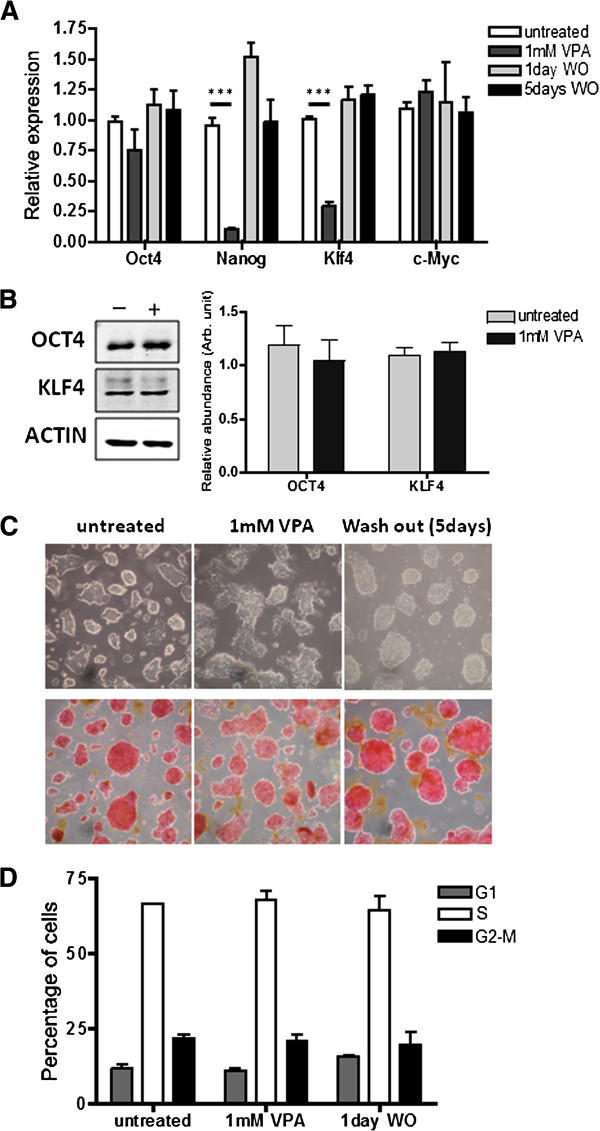
Valproic acid reduces expression of selected pluripotency genes but does not trigger long-term changes in cell growth or differentiation. (A) Embryonic stem (ES) cells (CCE/R) were treated for 8 h with 1 mM valproic acid (VPA) followed by culture for one or five days in the absence of the drug (wash out, WO). The expression of four pluripotency-associated genes was quantified by real time-quantitative (RT-q)PCR, relative to the expression of β-actin, in untreated, VPA-treated and WO cells. Error bars represent the standard error (SE) of the mean of independent experiments (n = 3). To assess the significance of a change, two-tailed unpaired t-tests were performed using GraphPad software; ***P < 0.001. (B) Levels of OCT4 and KLF4 proteins were checked before (left lane) and after (right lane) VPA treatment by western blotting. A measure of the secondary antibody fluorescent signal, normalised to the β-actin signal, allowed a quantitative representation of changes. Error bars indicate SE from 3 independent experiments. (C) Light microscopy was used to assess the cell morphology at each timepoint (upper panels). Alkaline phosphatase activity (red staining) was used as a marker of pluripotency (lower panels, pictures taken using 20× magnification). (D) ES cells were stained with propidium iodide (PI) and analysed by flow cytometry to obtain the mean percentage of cells in each phase of the cell cycle before and after VPA treatment and WO (n = 3).